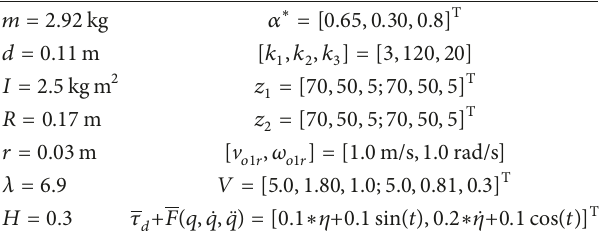
Table 1: Parameters used for the